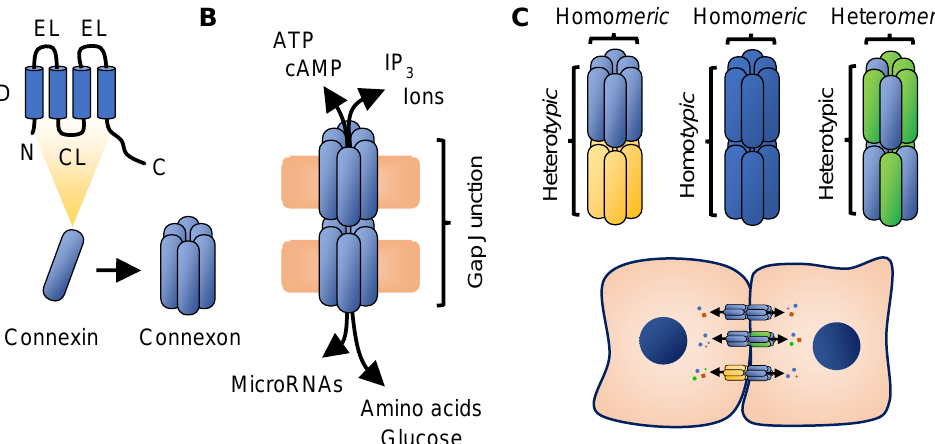
Figure 1. Canonical role of connexins in gap junctional intercellular communication. ( A ) Connexin proteins contain four transmembrane domains (TD), intracellular facing N- and C-terminal regions, two extracellular loops (EL) and one cytoplasmic loop (CL). C-terminal tail and CL are sites of post-translational modifications that affect many aspects of connexin biology. Six connexins form a hexameric channel known as a connexon which forms a highly regulated aqueous pore. ( B ) Connexons are inserted into the plasma membrane and connexons on opposing cell membranes connect to form a gap junction, capable of direct transfer of small molecules and ions. Interactions between ELs are important for formation of gap junctions while other domains mediate different aspects of channel permeability and gating properties. ( C ) Connexons composed of a single type of connexin are termed homomeric while connexons formed from multiple connexins are heteromeric. Gap junctions formed between the same homomeric channels are termed homotypic while connexon docking of differing homomeric channels, or between heteromeric channels are termed heterotypic. The multitude of permutations of these combinations affect the type and directionality of substrate transfer between cells.